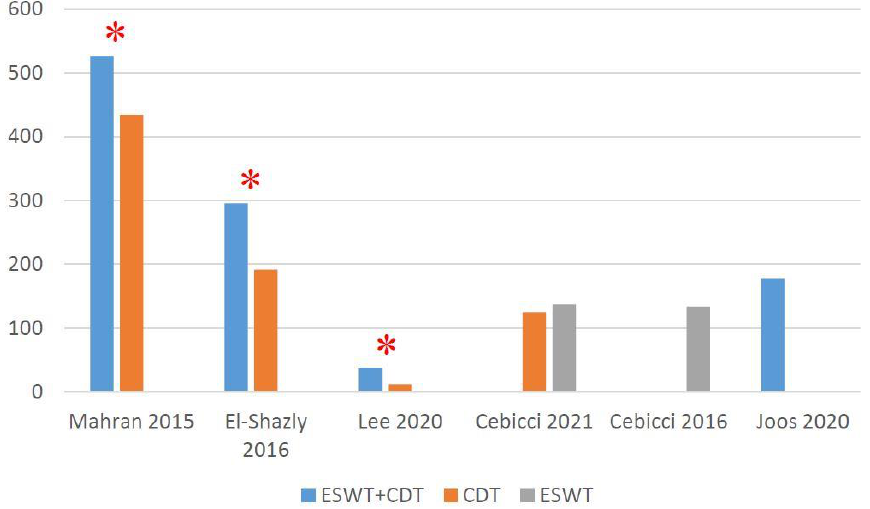
Figure 3. Absolute volume change (mL) from baseline at post-treatment. * Significant inter-group difference.